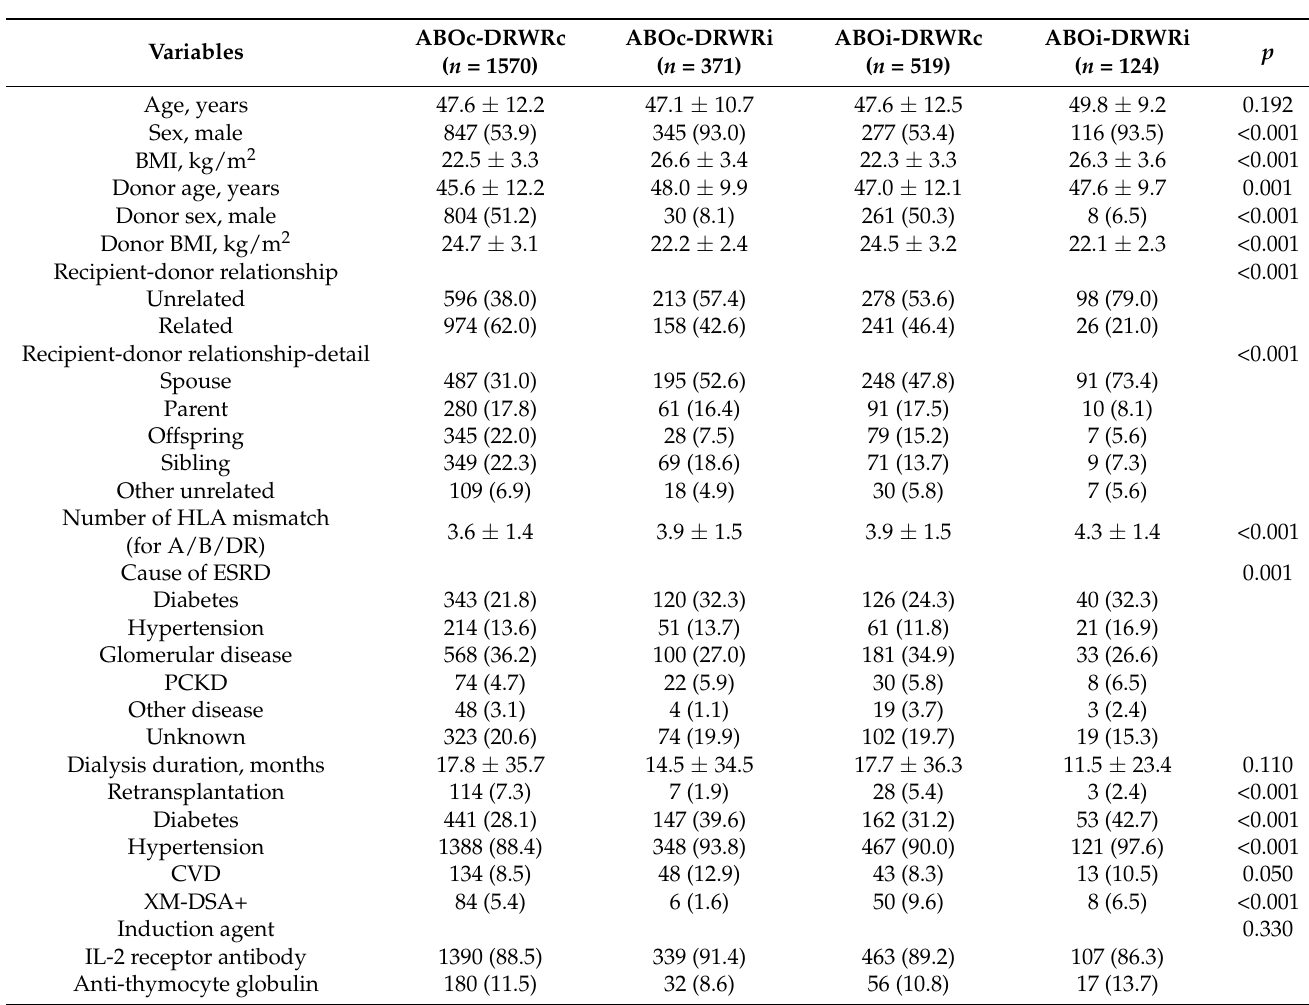
Table 1. Baseline